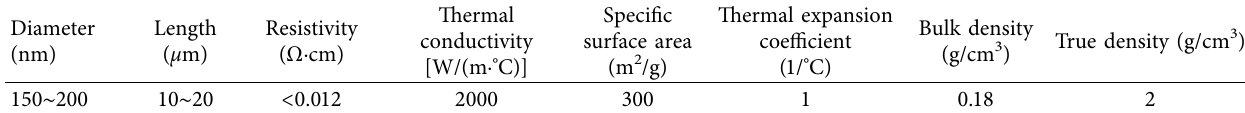
Table 2: Technical parameters of carbon nanofbers.